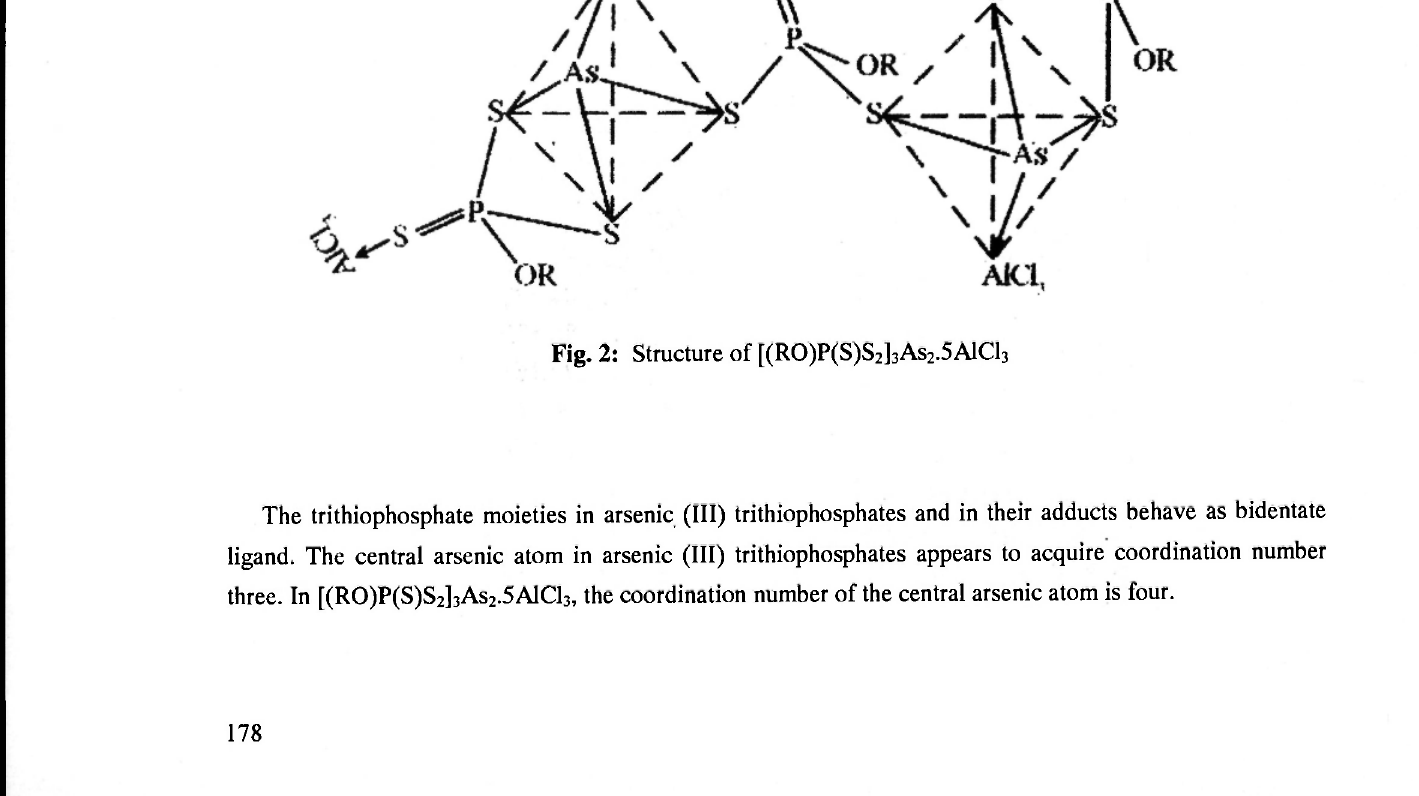
Fig. 1: Structure of [(RO )P (S)S